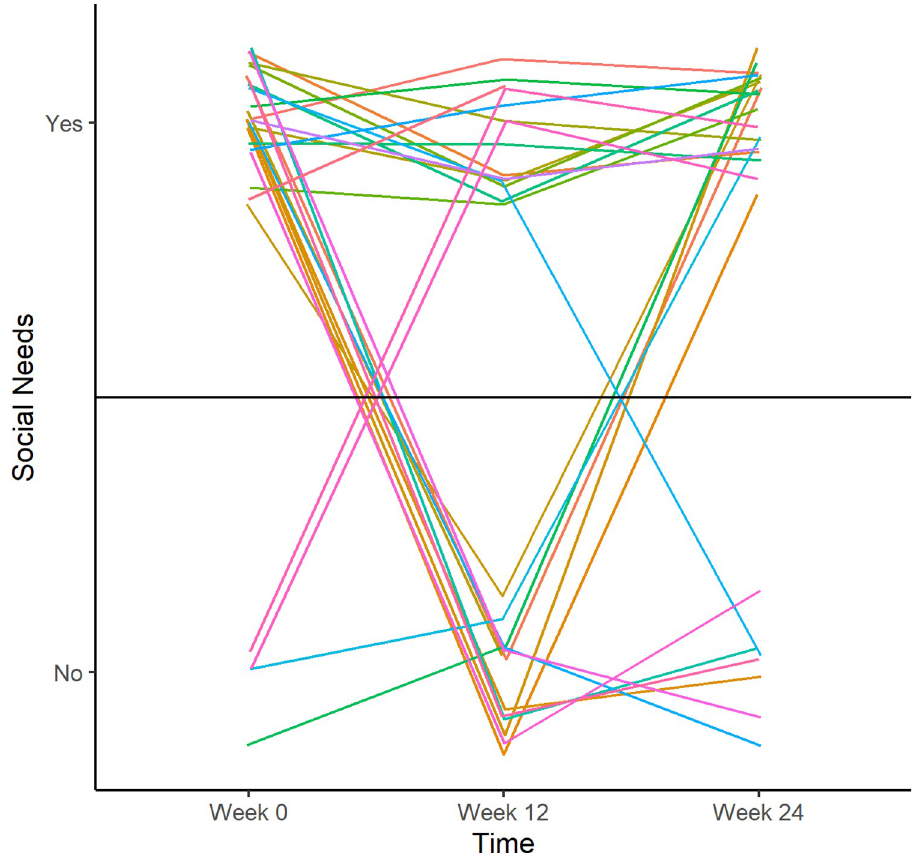
Fig 3. Non-medical health related social needs in black impact at 0, 12 and 24 Weeks. Lines represent the 44 participants that had social need(s) at some point during the study. Four had no social needs at baseline, then gained at least one social need as the study progressed. Forty had a social need at baseline. Thirteen of the 40 had no social needs by week 12, and one participant took until week 24 to resolve his social need(s). Six of the 13 that had social needs addressed by week 12 had regained social need(s) by week 24. The lines in the plot have random jitter added to allow individual participants to be